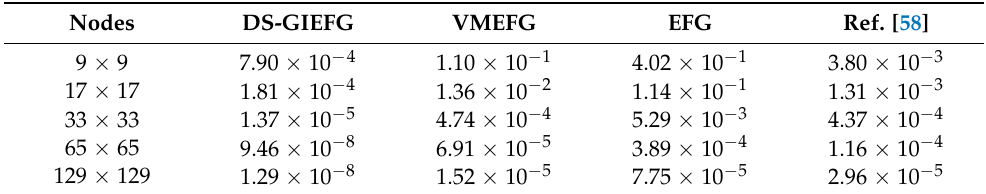
Table 1. The errors nodes